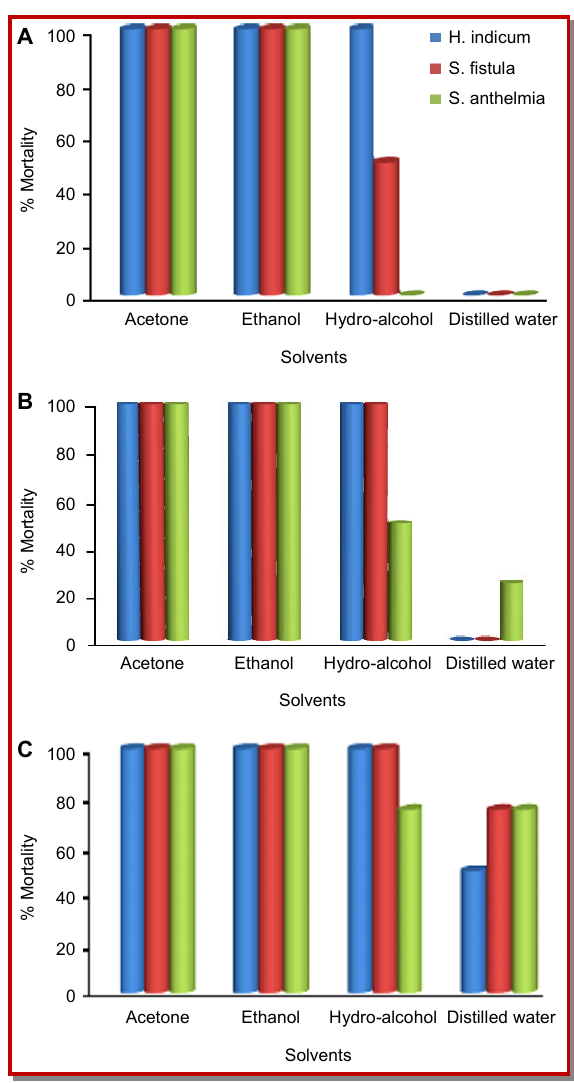
Figure 1: Comparative percentage mortality of 0.25 mg/mL (A), 0.5 mg/mL (B) and 1.0 mg/mL (C) of the extracts against adult earth worm ( Pheretima posthum